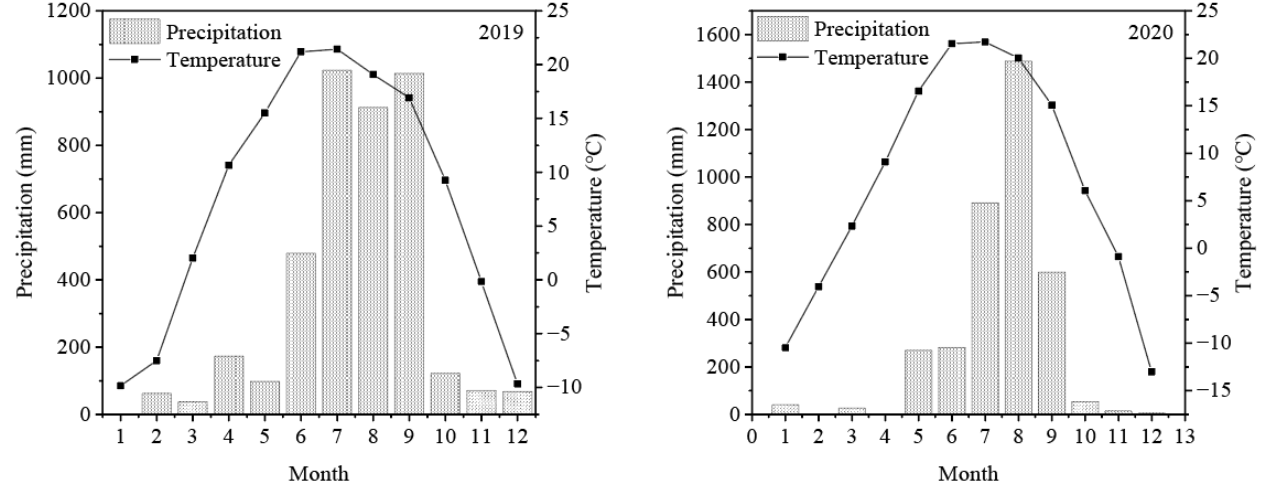
Figure 1. Monthly precipitation (bar) and mean air temperature (curve) of the experiment site from 2019 to 2020. Table 1. Basic characteristics of the tested soil.